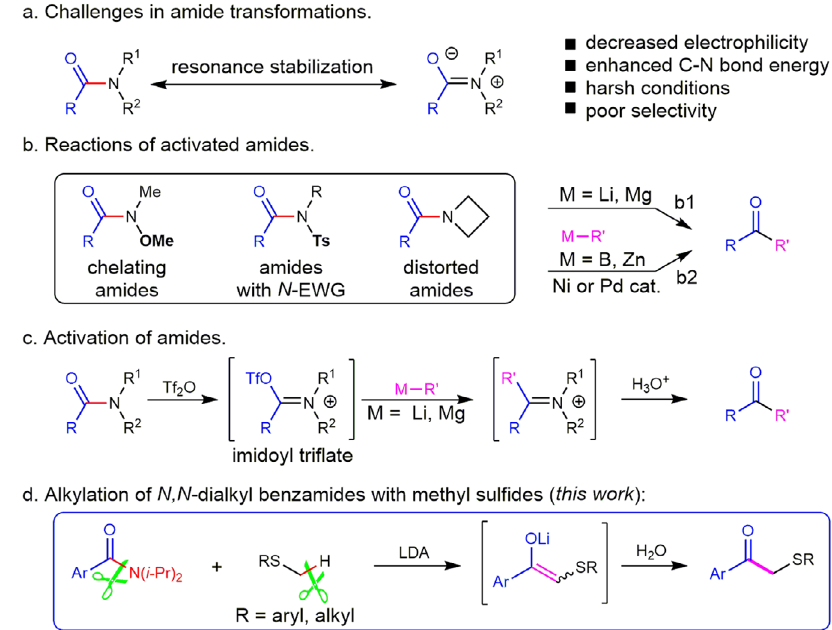
Fig. 1 Amides transformations. a Challenges in amide transformation. b Activated amides. c Amides activation. d This work: Alkylation of N, N -dialkyl benzamides with methyl sul fi